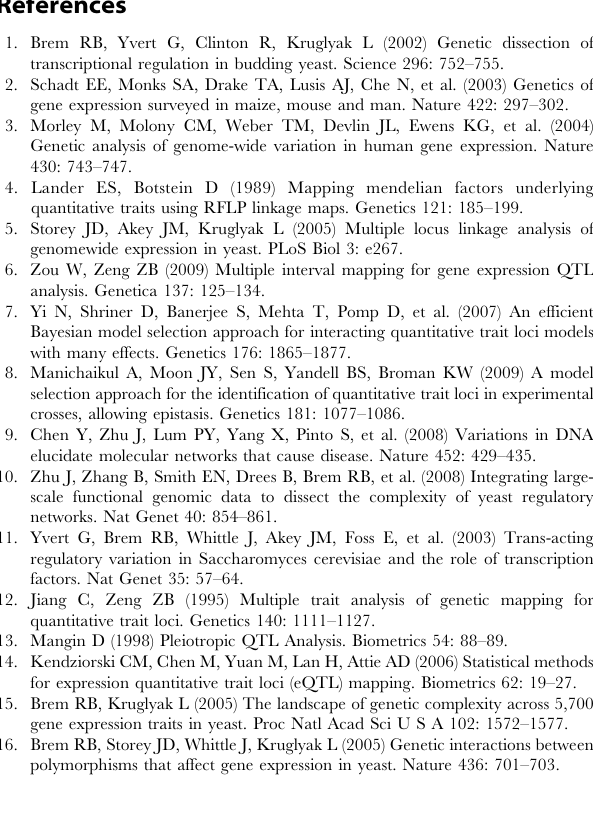
Table S1 Design for the simulation II. Table S2 True markers and inferred markers in each module. Table S3 Enrichment of (A) gene knockout signatures and (B) TFBS for each